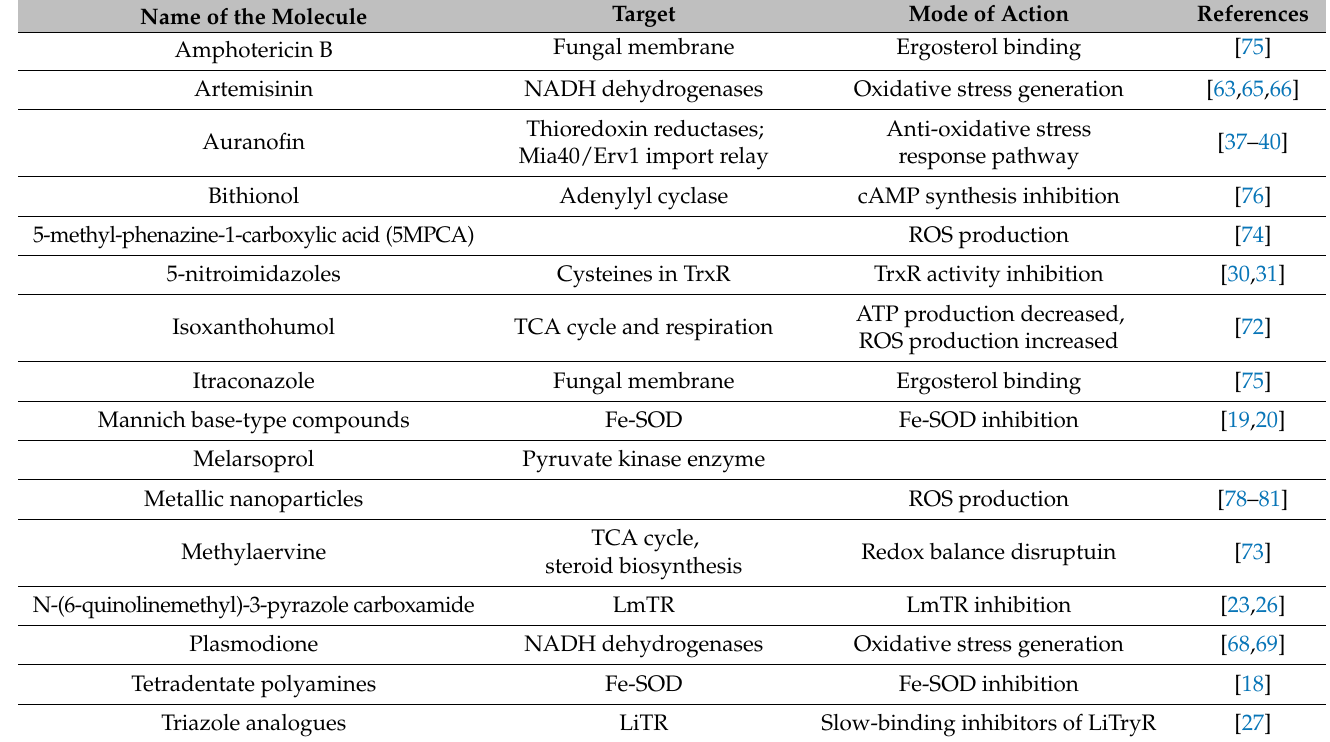
Table 1. List of molecules presented throughout this